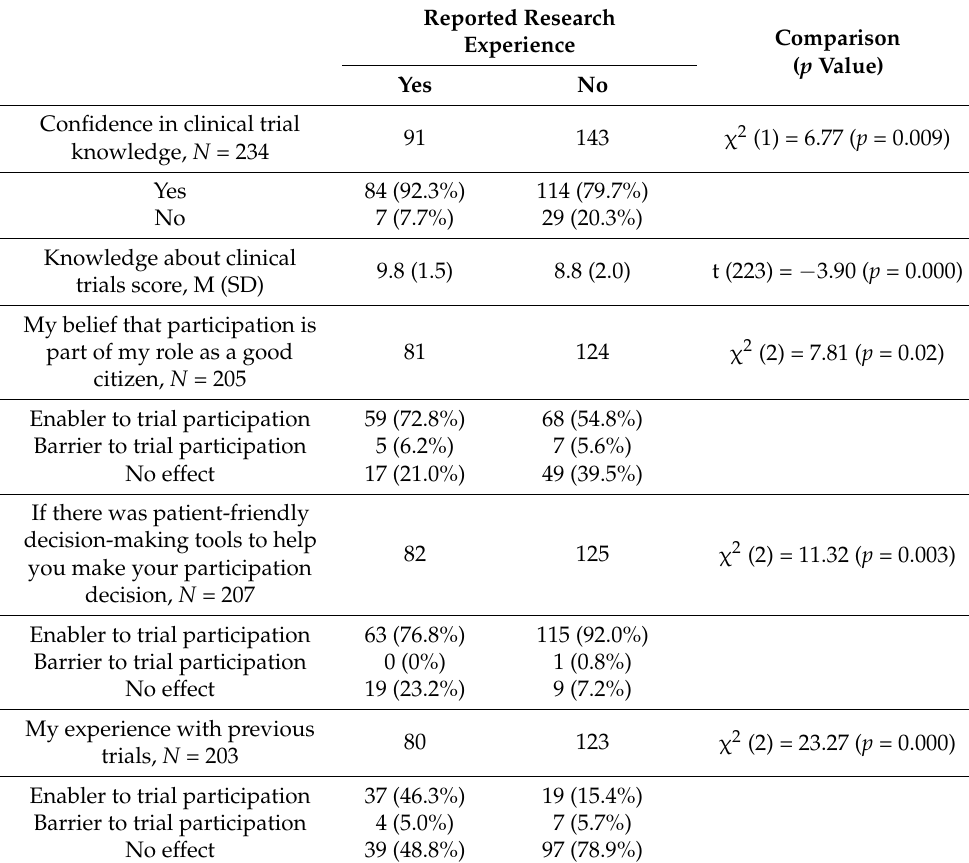
Table 4. Differences in confidence and knowledge about clinical trials and reported barriers/enablers to participation for those with and without research experience. Reported